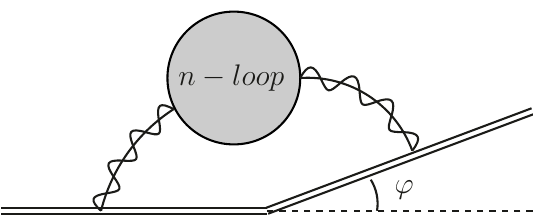
Figure 4 . The contribution to the vacuum expectation value of the cusped Wilson line arising from the a single, loop corrected, propagator | of the gluon or of the